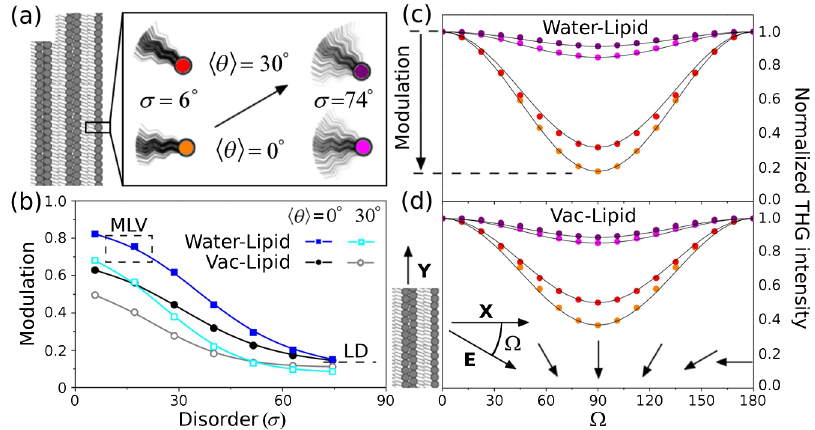
FIG. 3. Calculated P-THG response as a function of lipid order parameters. (a) The components of (cid:3) ð 3 Þ ML are determined by the physical distribution of lipid angles relative to the X axis. A low angle and low (cid:8) correlate with the highest P-THG modulation. The arrow points from the highest-modulation parameters to lowest. (b) Calculated modulation amplitude as a function of lipid parameters and interface type. Modulation is generally higher at lipid-water (blue curves) than at vacuum-lipid (grey curves) interfaces, showing the increased sensitivity to anisotropy due to the partial (cid:3) ð 3 Þ matching. The modulation is also consistently larger for the liquid-phase lipids (closed symbols) relative to the gel-phase (open symbols) lipids for a particular interface type. Experimental values for the modulation in the MLV and lipid droplet (LD) are indicated with dashed lines. (c),(d) The calculated angular profiles for four multilamellar lipids, color-coded to match (a). The P-THG signal is lowest when the excitation field is parallel to the bilayers. The fitting curves are of the form I ¼ A þ B cos ð (cid:3) Þ 2